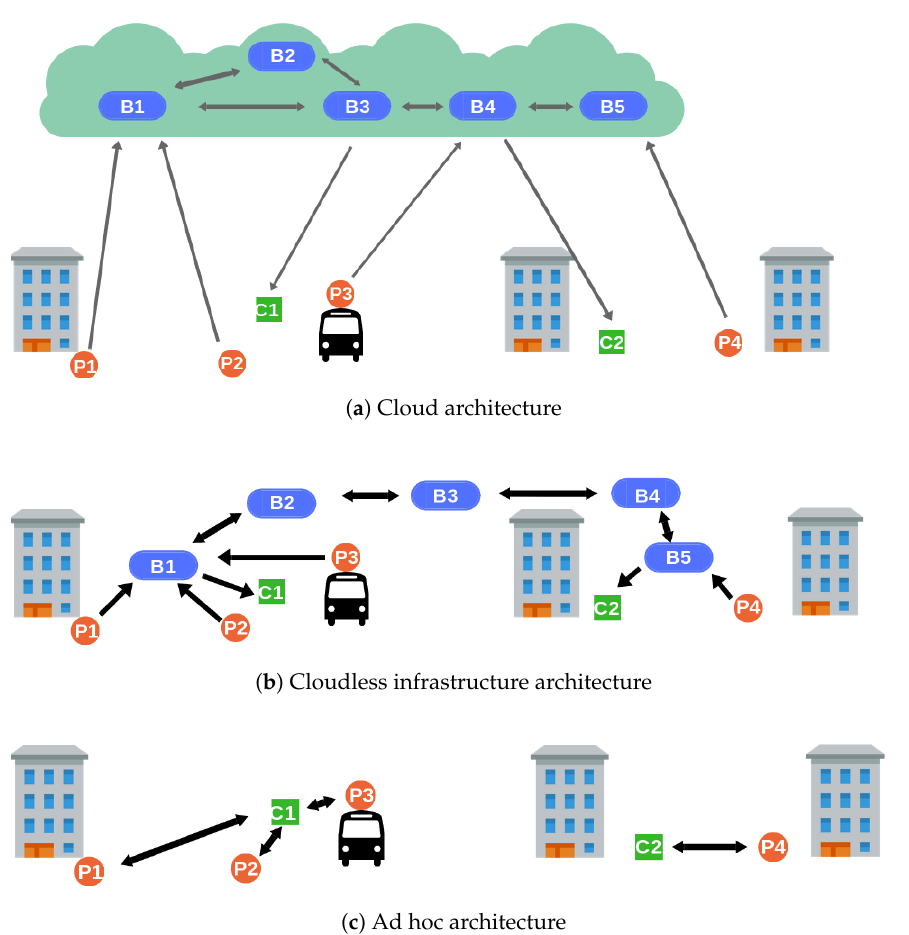
Figure 1. Participatory sensing